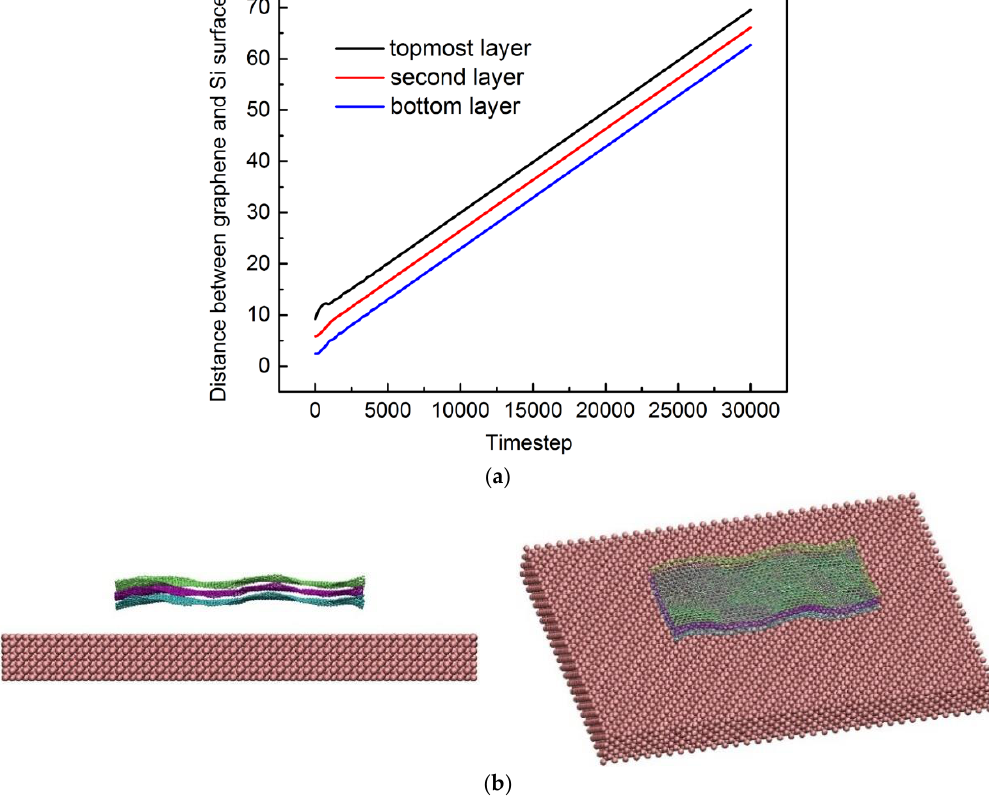
Figure 4. Adhesion behavior in a three-layer graphene system, when the vertical upward velocity is 9 Å /ps: ( a ) The variation of distance between graphene and the Si substrate surface with timestep; ( b ) atomic trajectory of the three-layer graphene system.